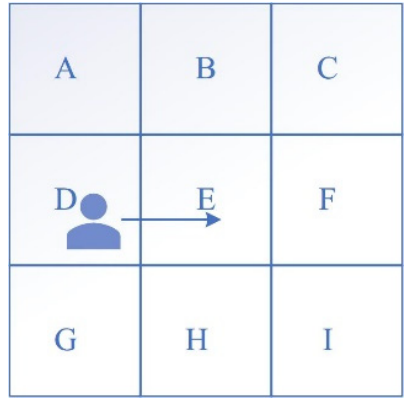
Figure 7. An example for risk level changes.